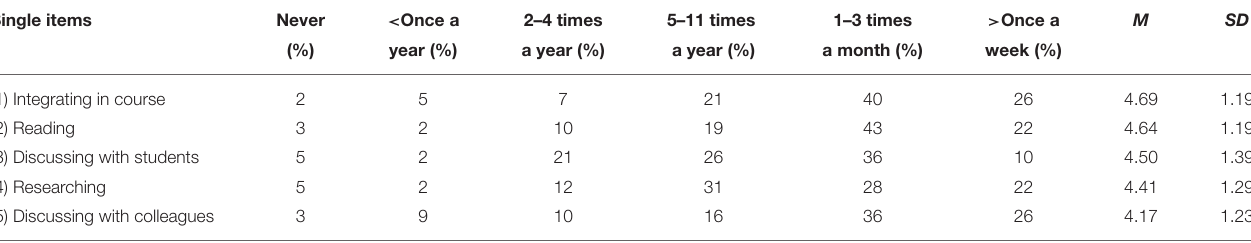
TABLE 4 | Descriptive statistics for intensity of use: percentage of nominations, mean scores (M), and standard deviation (SD) of single items. Single items